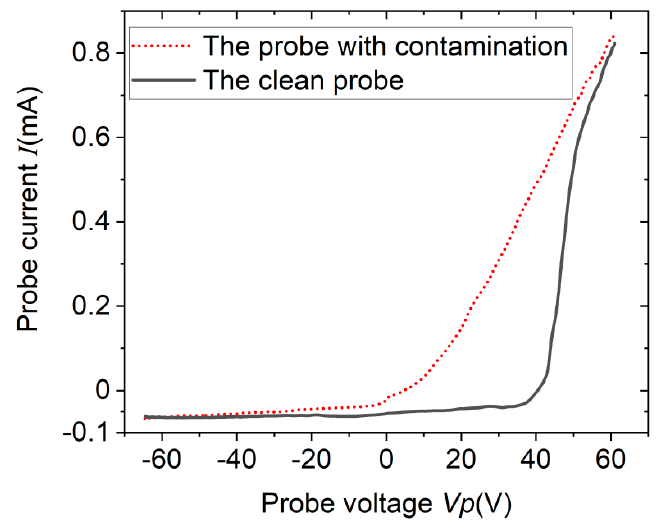
Figure 7. The I–V curve of the clean Langmuir probe and the probe with contaminations driven by DC supply.